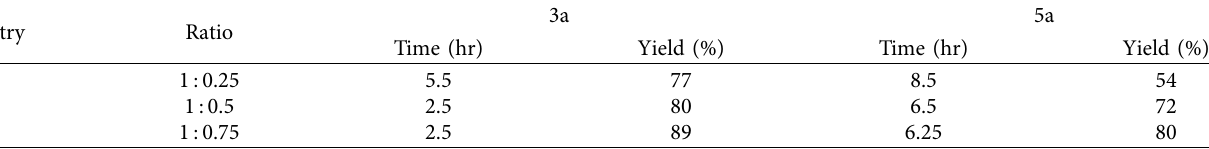
Table 2: Screening of catalyst